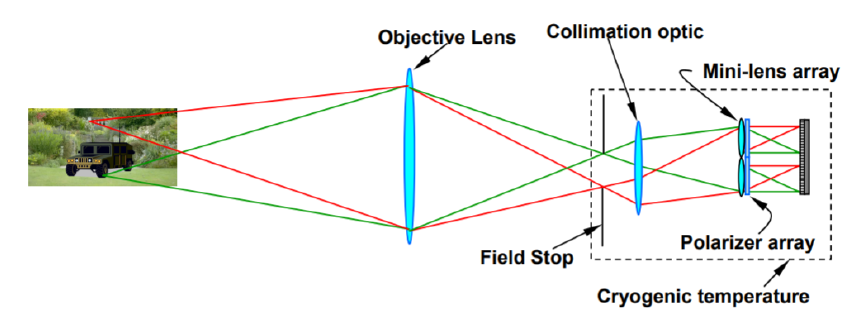
Figure 8. Schematic diagram of polarization imaging with sub-aperture [29].